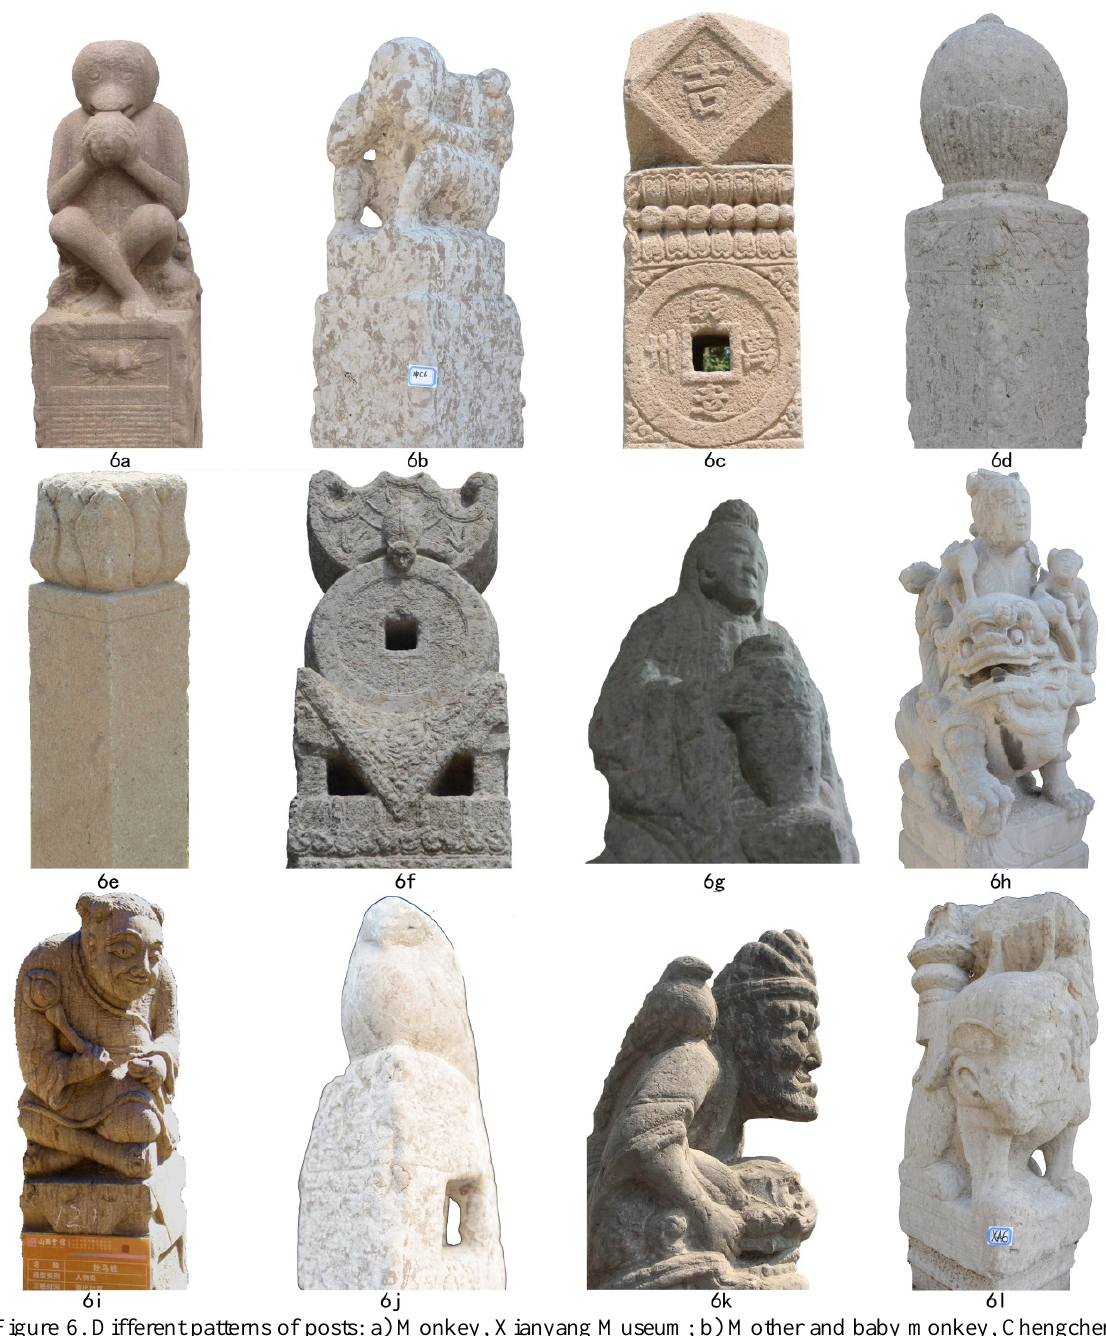
Figure 6. Different patterns of posts: a) Monkey, Xianyang Museum; b) Mother and baby monkey, Chengcheng county museum; c) Fortune symbol – Orb, Fengguosi temple, Liaoning province; d) Fortune symbol – peach, Chengcheng county museum; e) Fortune symbol – bud or lotus, Chengcheng county museum; f) Fortune